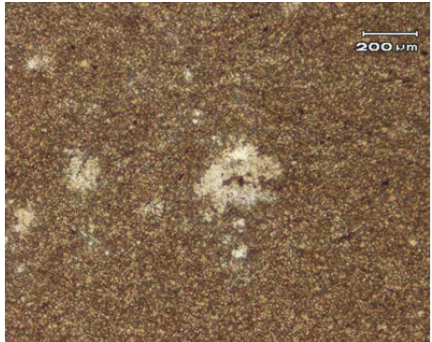
Figure 4: Dolarenite, S1, 3585.04 ∼ 3585.16 m, T 1 j 2 .